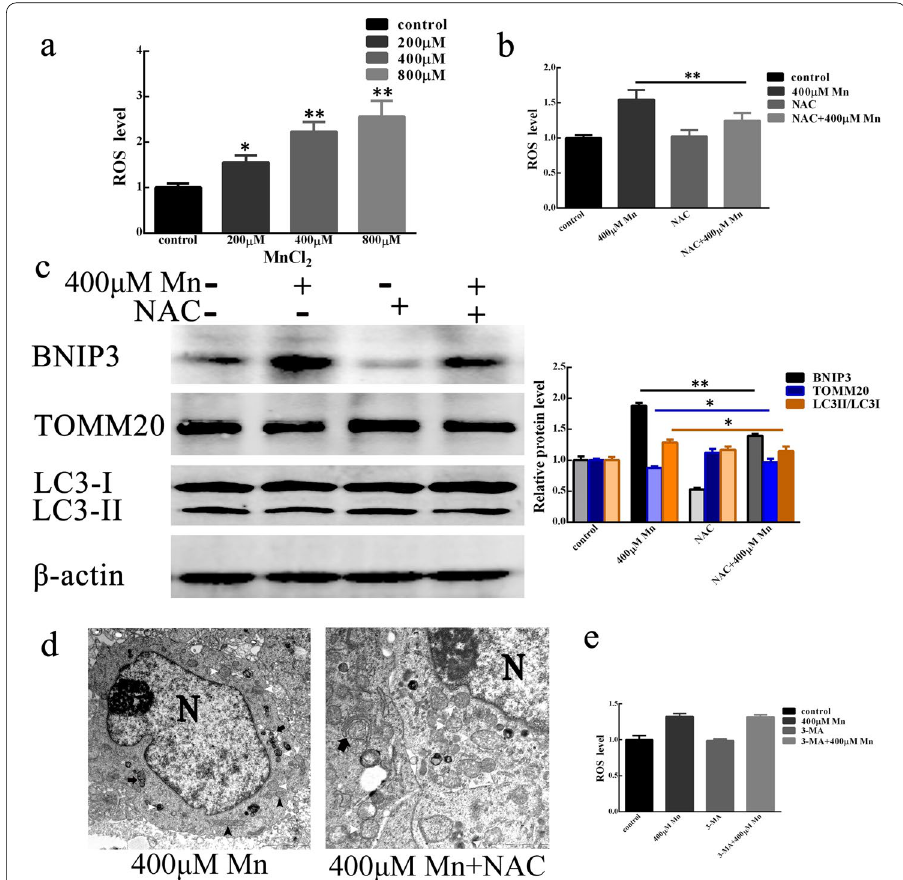
Fig. 3 MnCl 2 induced mitophagy by regulating ROS generation. a , b SH-SY5Y cells were treated with 200, 400, and 800 µM MnCl 2 ( a ) and 400 µM MnCl 2 with or without pretreatment with the antioxidant NAC ( b ) for 24 h. ROS levels were measured using a microplate reader. c BNIP3, LC3 and TOMM20 protein levels were measured by western blot after treatment with 400 µM MnCl 2 with or without pretreatment with the antioxidant NAC for 24 h. β-actin served as the internal reference. Compared with control, * P < 0.05, ** P < 0.01. d Mitophagy bodies and mitochondria were observed by transmission electron microscopy (TEM) in cells treated with 400 μM MnCl2 alone or co-treated with the mitophagy inhibitor NAC for 24 h. N, nucleus. White arrow, expanded, condensed or dissolved, mitochondria aggregates. Black arrow ( ), relatively normal mitochondrial morphology. Black arrow ( ), mitophagy bodies. e After co-treatment with or without the autophagy inhibitor 3-MA, ROS levels in SH-SY5Y cells were also measured using a microplate